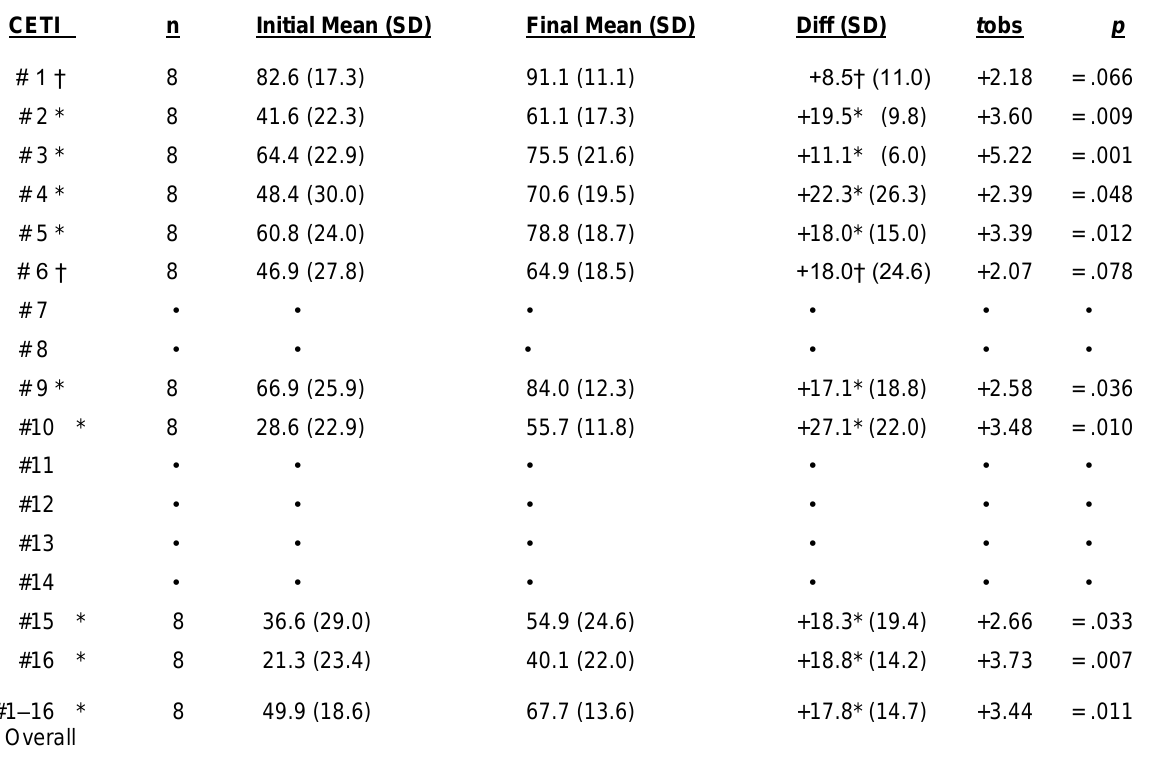
Table 4. CETI (Functional Communication) Changes in SCALE Participants with Chronic Aphasia Following Remote Therapy and On-line